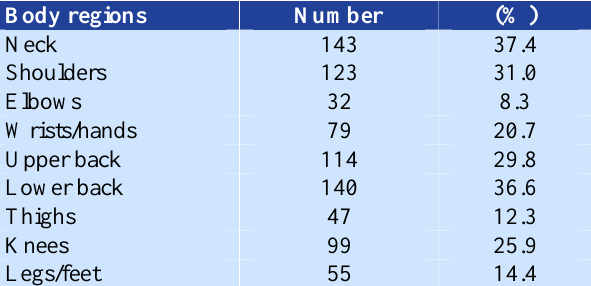
Table 2. Musculoskeletal symptoms in various body regions during the 12 months before their including